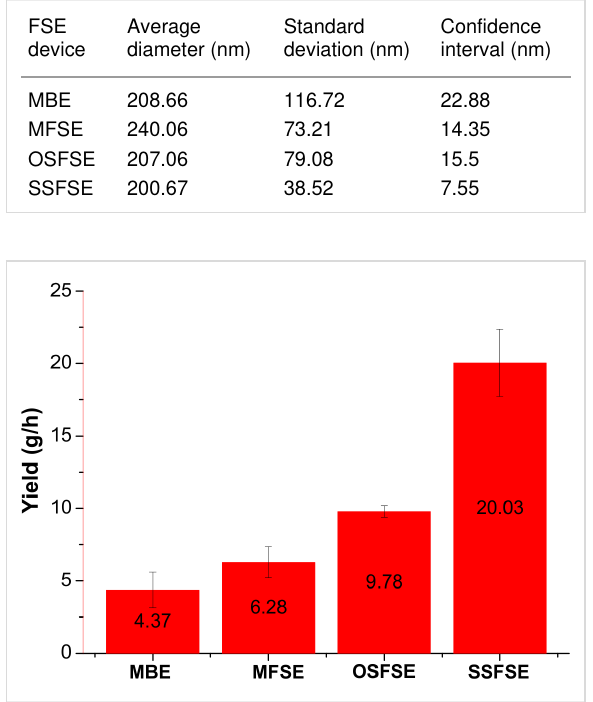
Figure 12: Yields of the PAN nanofibers produced using the different